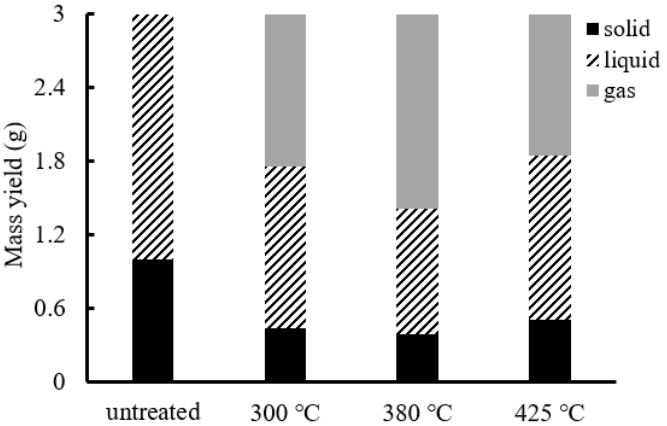
Figure 10. Mass balance of HTG (group 2).